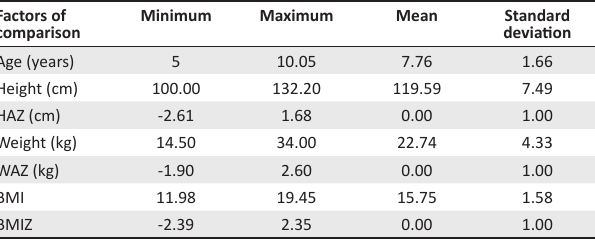
TABLE 1: Demographic and anthropometric results of participants ( n =